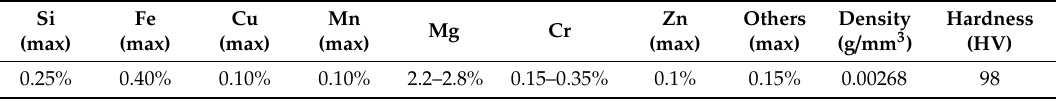
Table 1. Chemical composition and physical properties of aluminum alloy